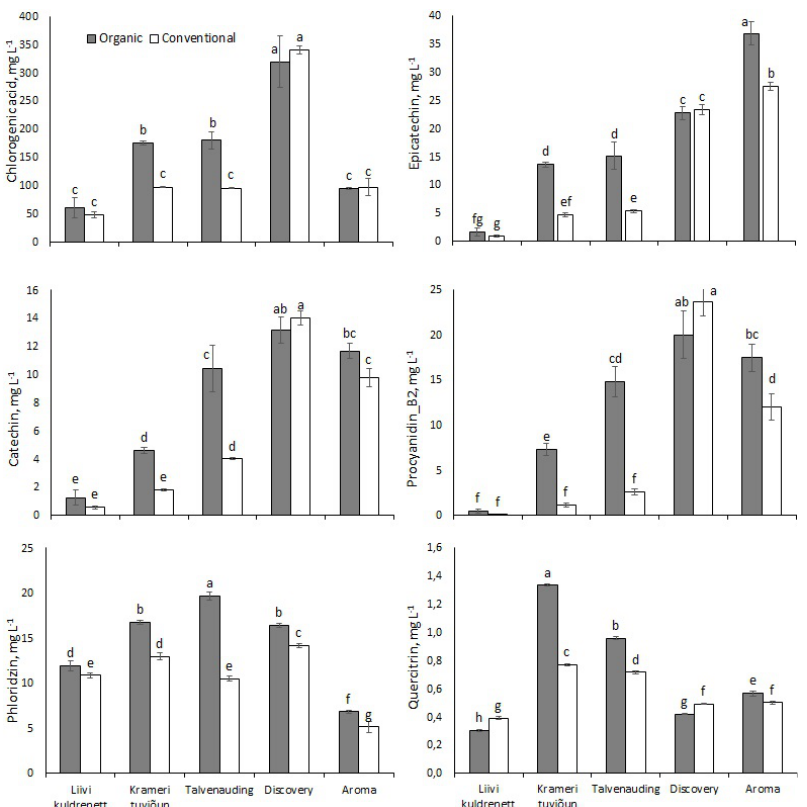
Fig. 2. Concentration of polyphenols in Estonian (‘Liivi kuldrenett’, ‘Krameri tuviõun’ and ‘Talvenauding’) and Norwegian (‘Discovery’ and ‘Aroma’) apple juices as affected by apple